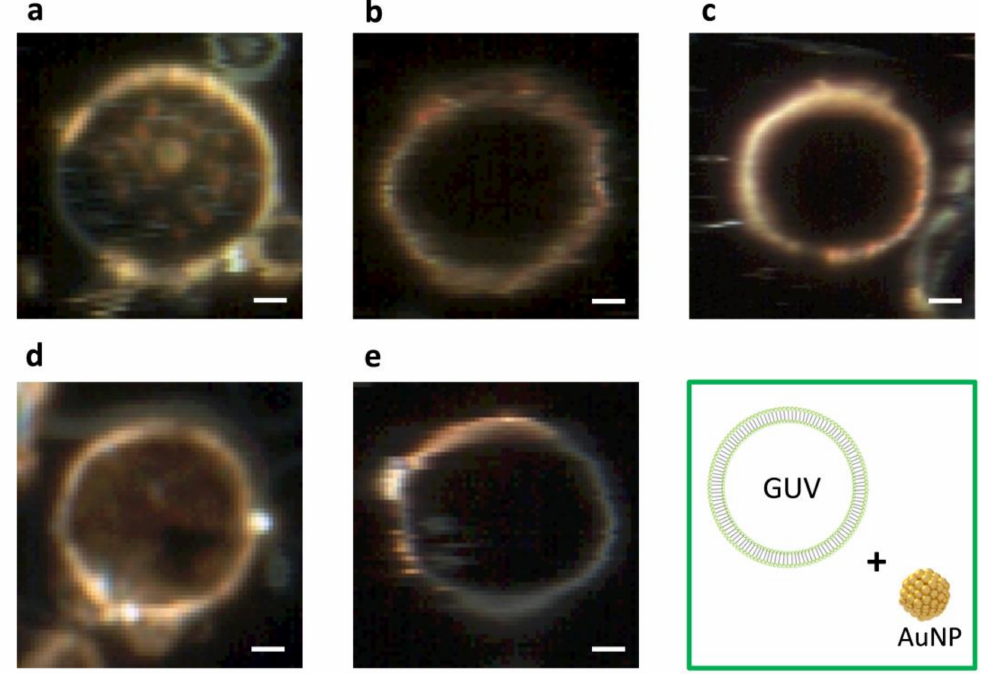
Figure 6. DFM images of GUV+AuNPs where GUVs are of varied composition including ( a ) DMPC only, ( b ) 10 mol%, ( c ) 20 mol%, ( d ) 30 mol%, and ( e ) 40 mol% CHOL:DMPC, respectively. Scale bars are 5 µ